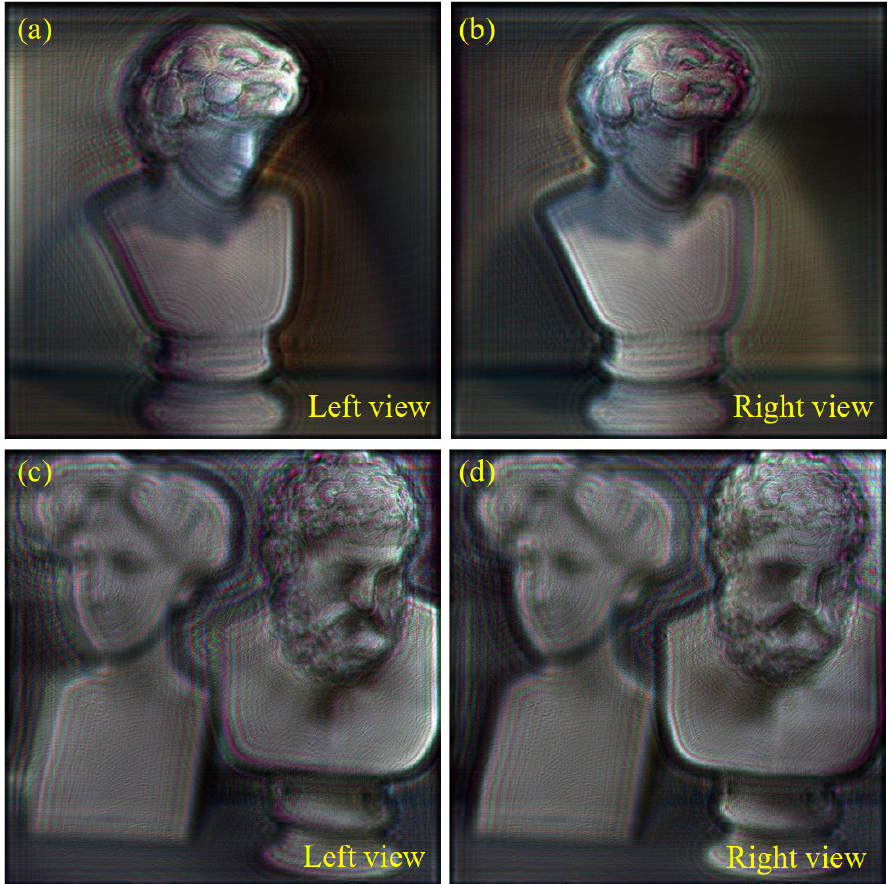
Figure 3. Reconstructed images from motion parallax holograms from left and right view positions. ( a) and ( b ) show the reconstructed images of “Antinous.” with motion parallax from left and right views. ( c ) and ( d ) show the reconstructed images of “Greek.” with motion parallax from left and right views. We used the 3D model provided from [19].